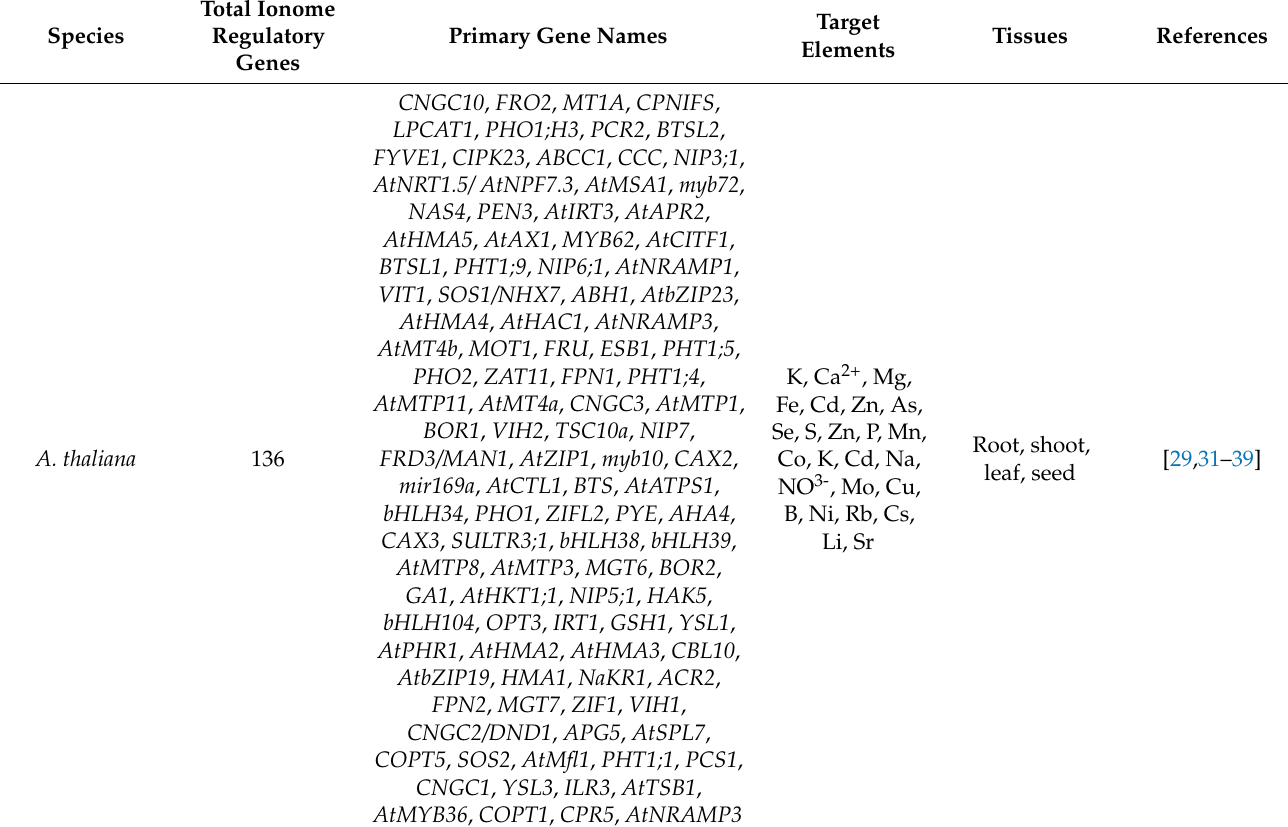
Table 1. List of primary genes and their elemental targets that affect plant ionome in different plant species. Total Species